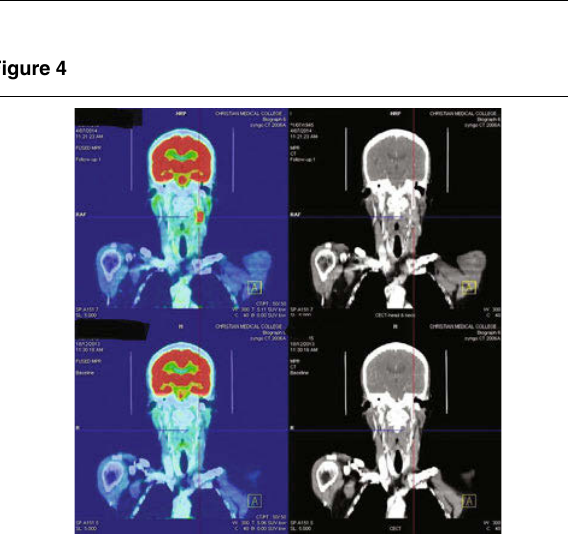
A linear band of increased 18 FDG uptake [standardized uptake value (SUV) = 3.65] is noted in the soft palate. Corresponding computed tomographic (CT) images show mild soft tissue thickening in the region of the soft palate.